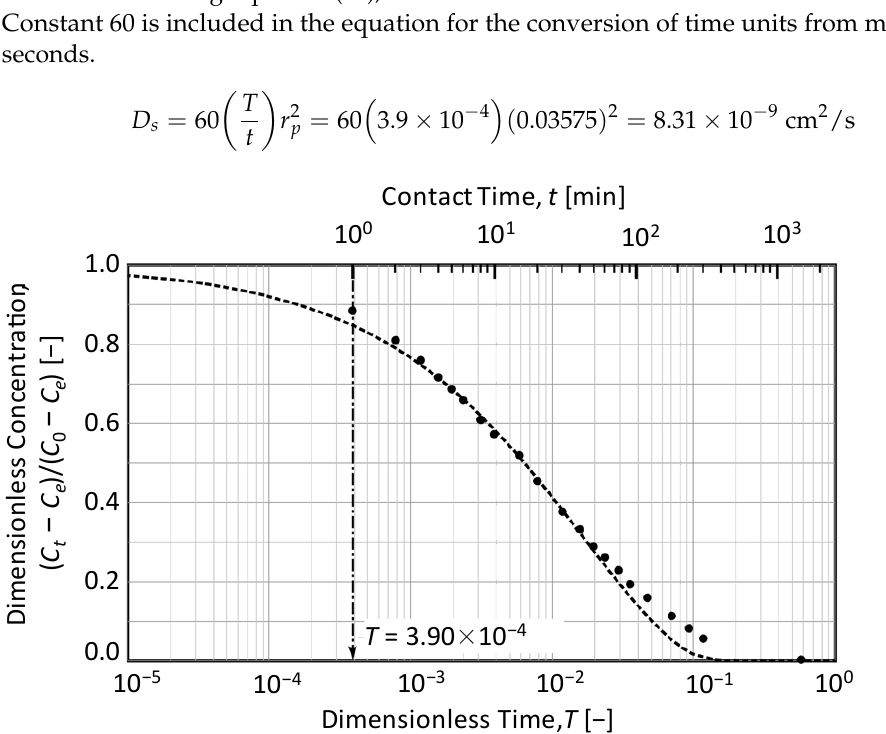
Figure 9. Comparison of the concentration decay curves obtained by the experiment and the numerical calculation of the theoretical model.